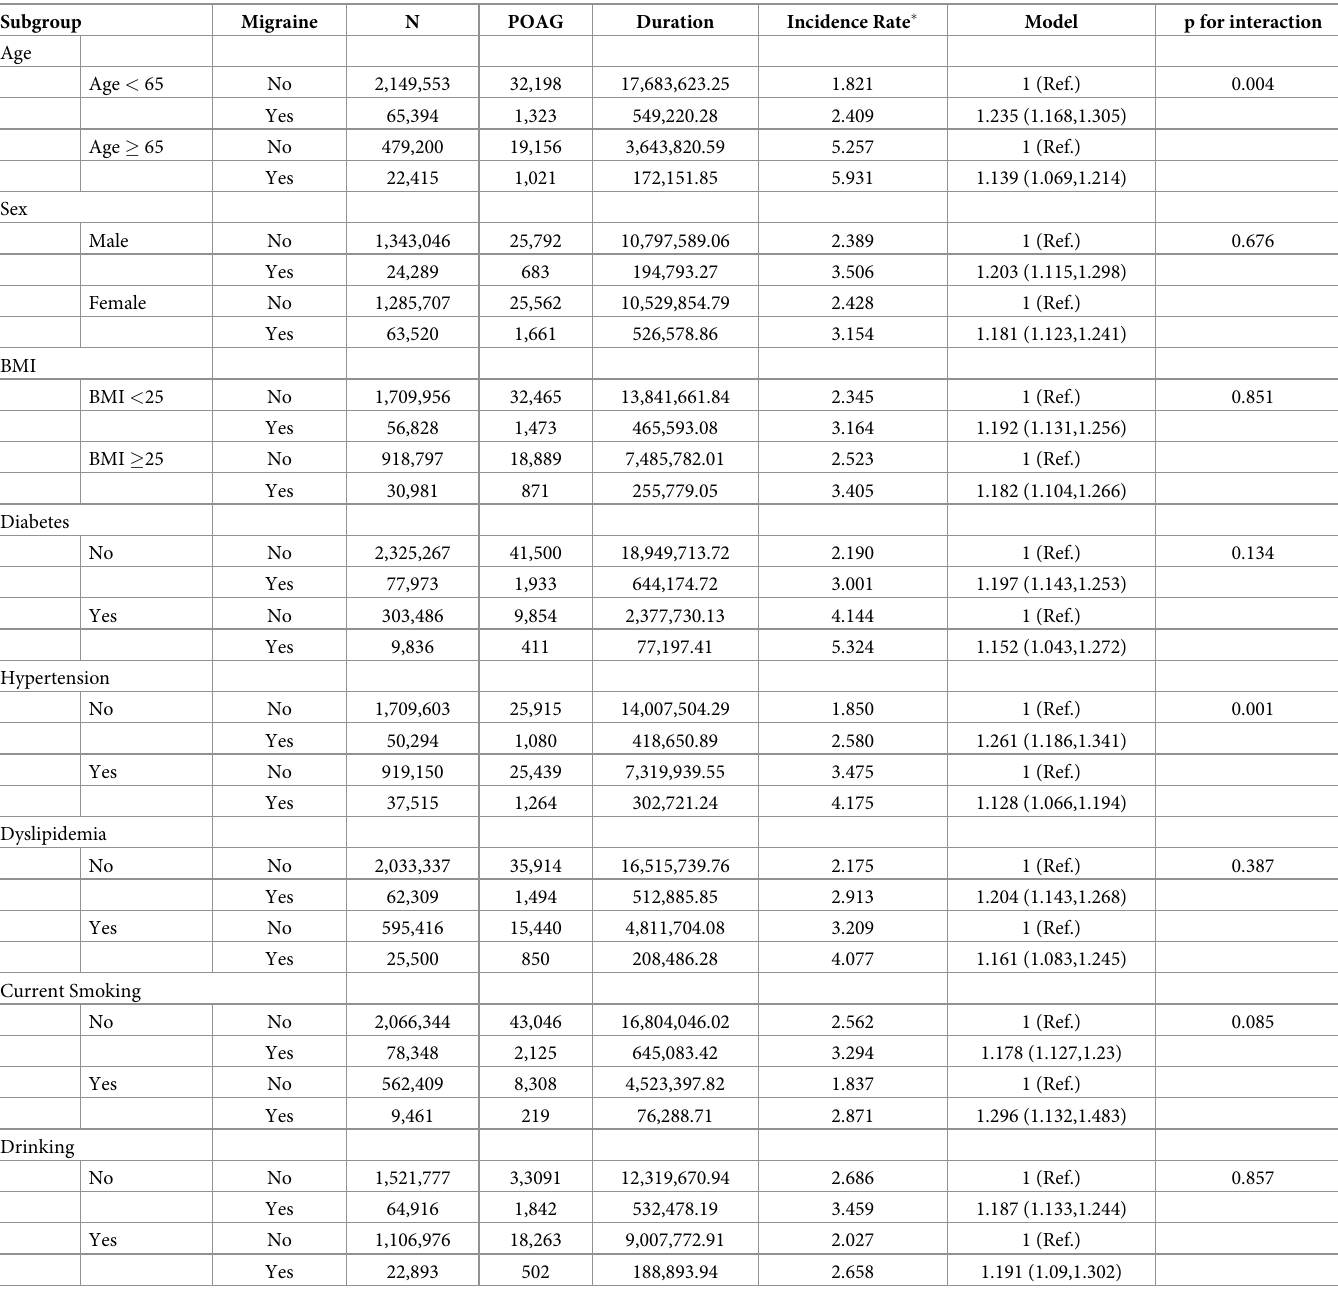
Table 3. Risk of POAG according to presence of migraine stratified by age, sex, body mass index, diabetes, hypertension, dyslipidemia, smoking, and drinking. Subgroup Migraine N POAG Duration Incidence Rate � Model p for